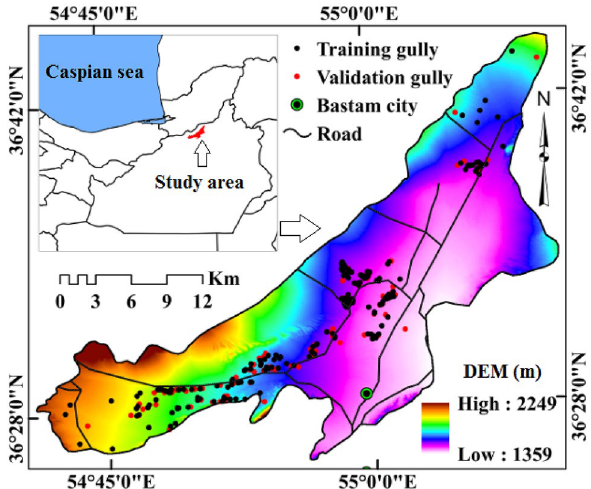
Figure 7. Location of study area in Iran. The map was generated using ArcGIS 10.5 software (https ://deskt op.arcgi